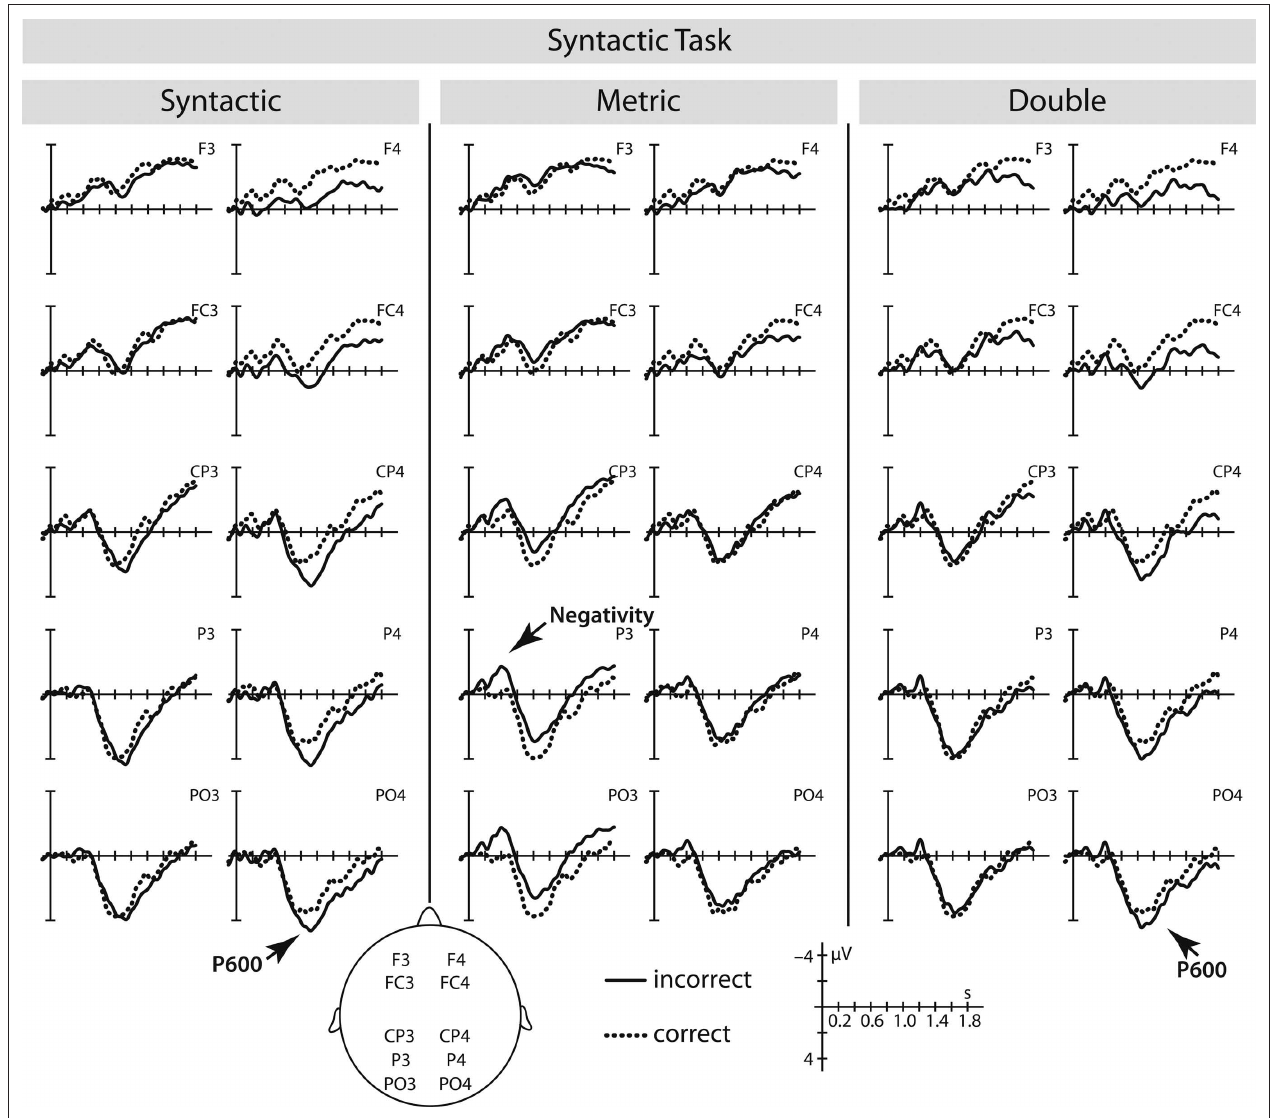
Figure 4 | Syntactic task – Spanish L2 learners: erPs elicited by the critical main verb in the syntactic, metric, and the double violation condition. Waveforms show the average for correct and the particular violation condition from 100 ms prior to the item onset up to